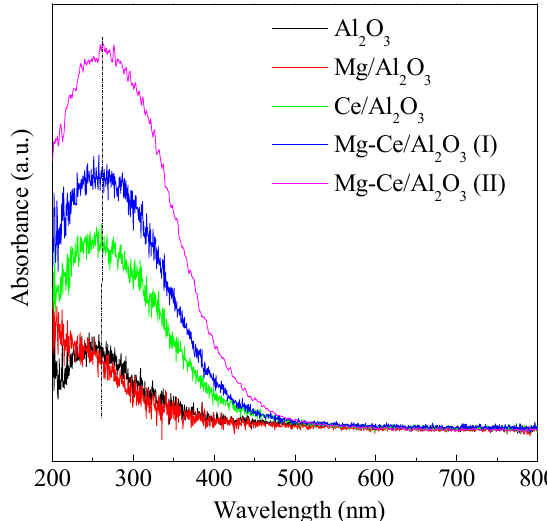
Figure 5. UV-vis patterns of Al 2 O 3 and metal oxide-loaded Al 2 O 3 Figure 5. UV ‐ vis patterns of Al 2 O 3 and metal oxide ‐ loaded Al 2 O 3 catalysts.